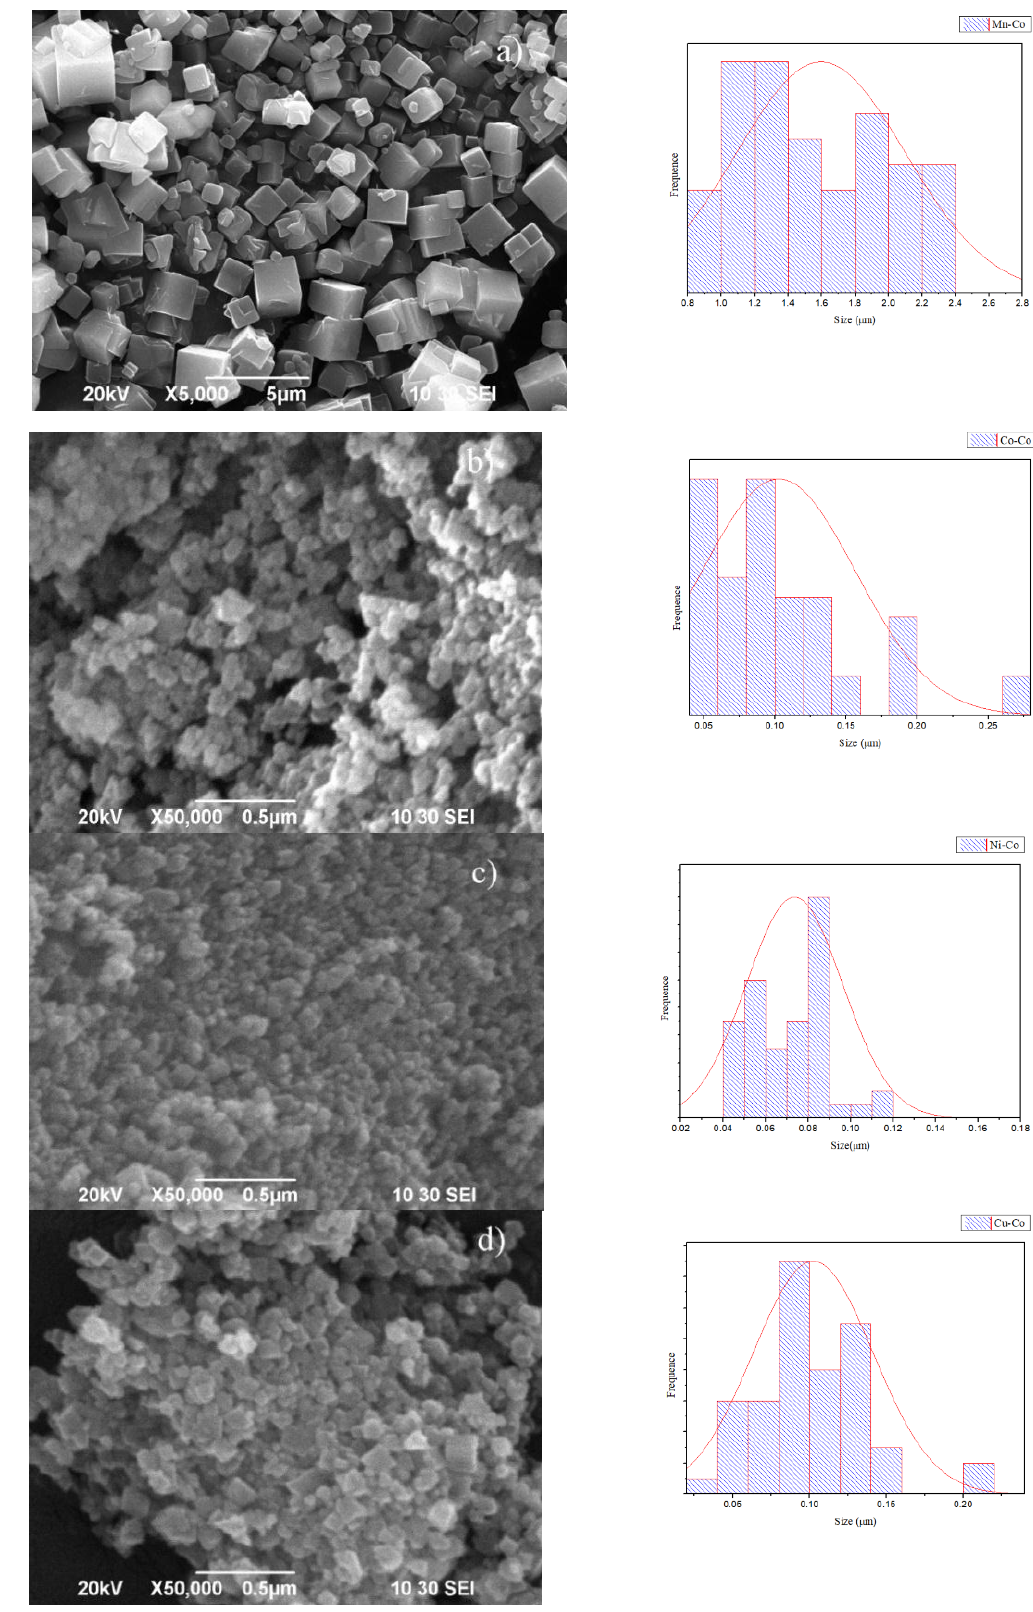
Figure 7. Scanning Electron Microscopy (SEM) images of ( a ) Mn–Co, ( b ) Co–Co, ( c ) Ni–Co, and ( d ) Cu–Co samples.